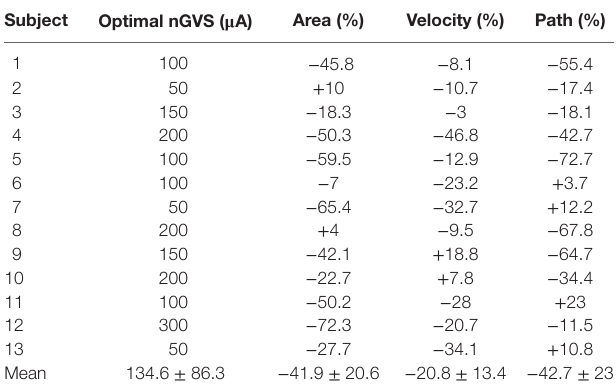
TaBle 1 | The optimal noisy galvanic vestibular stimulation (nGVS) amplitude of each subject and its effect on the three sway parameters in the medio-lateral plane are